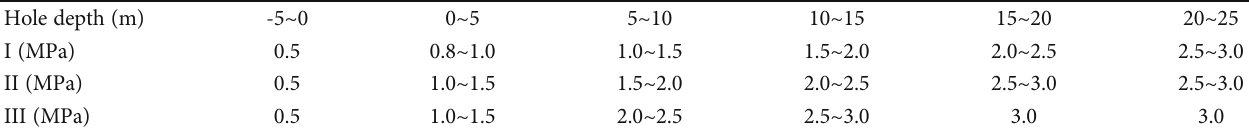
Table 6: Consolidation grouting pressure and length in the test